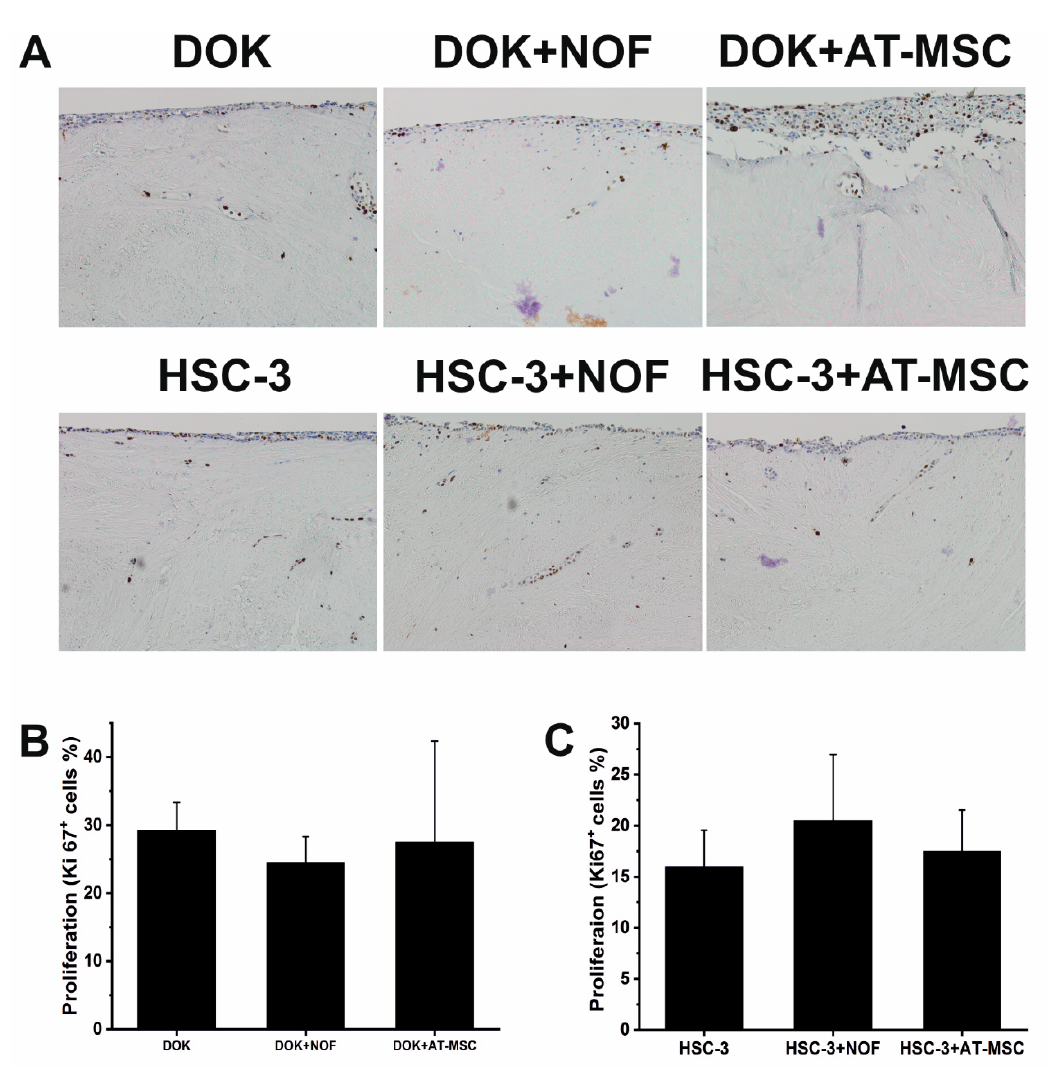
Figure 5. Proliferation of DOK and HSC-3 was not affected by the presence of AT-MSCs. ( A ) DOK and HSC-3 cells were co-cultured with AT-MSCs and NOF using a myoma organotypic model, pictures were taken at magnification 10×. ( B,C ) Ki67 was used as a marker for cell proliferation.